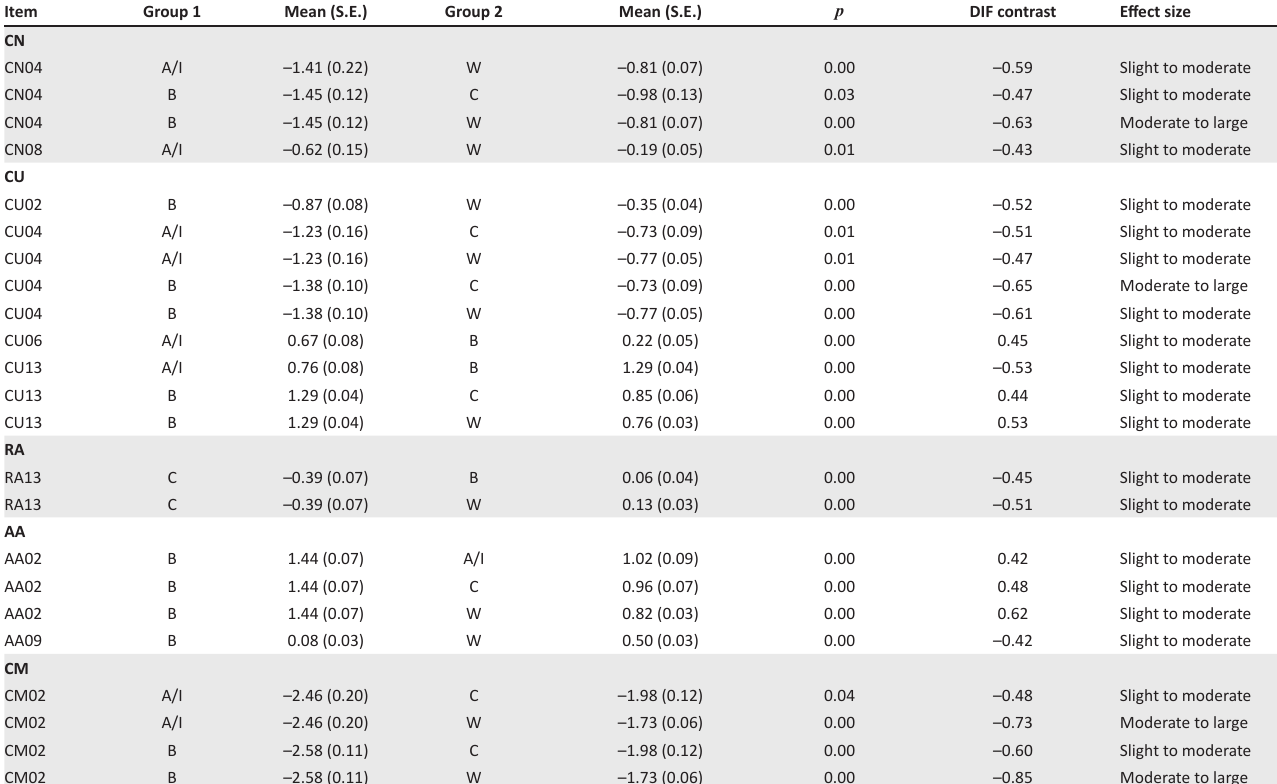
TABLE 6: Differential item functioning between ethnicity groups. Item Group 1